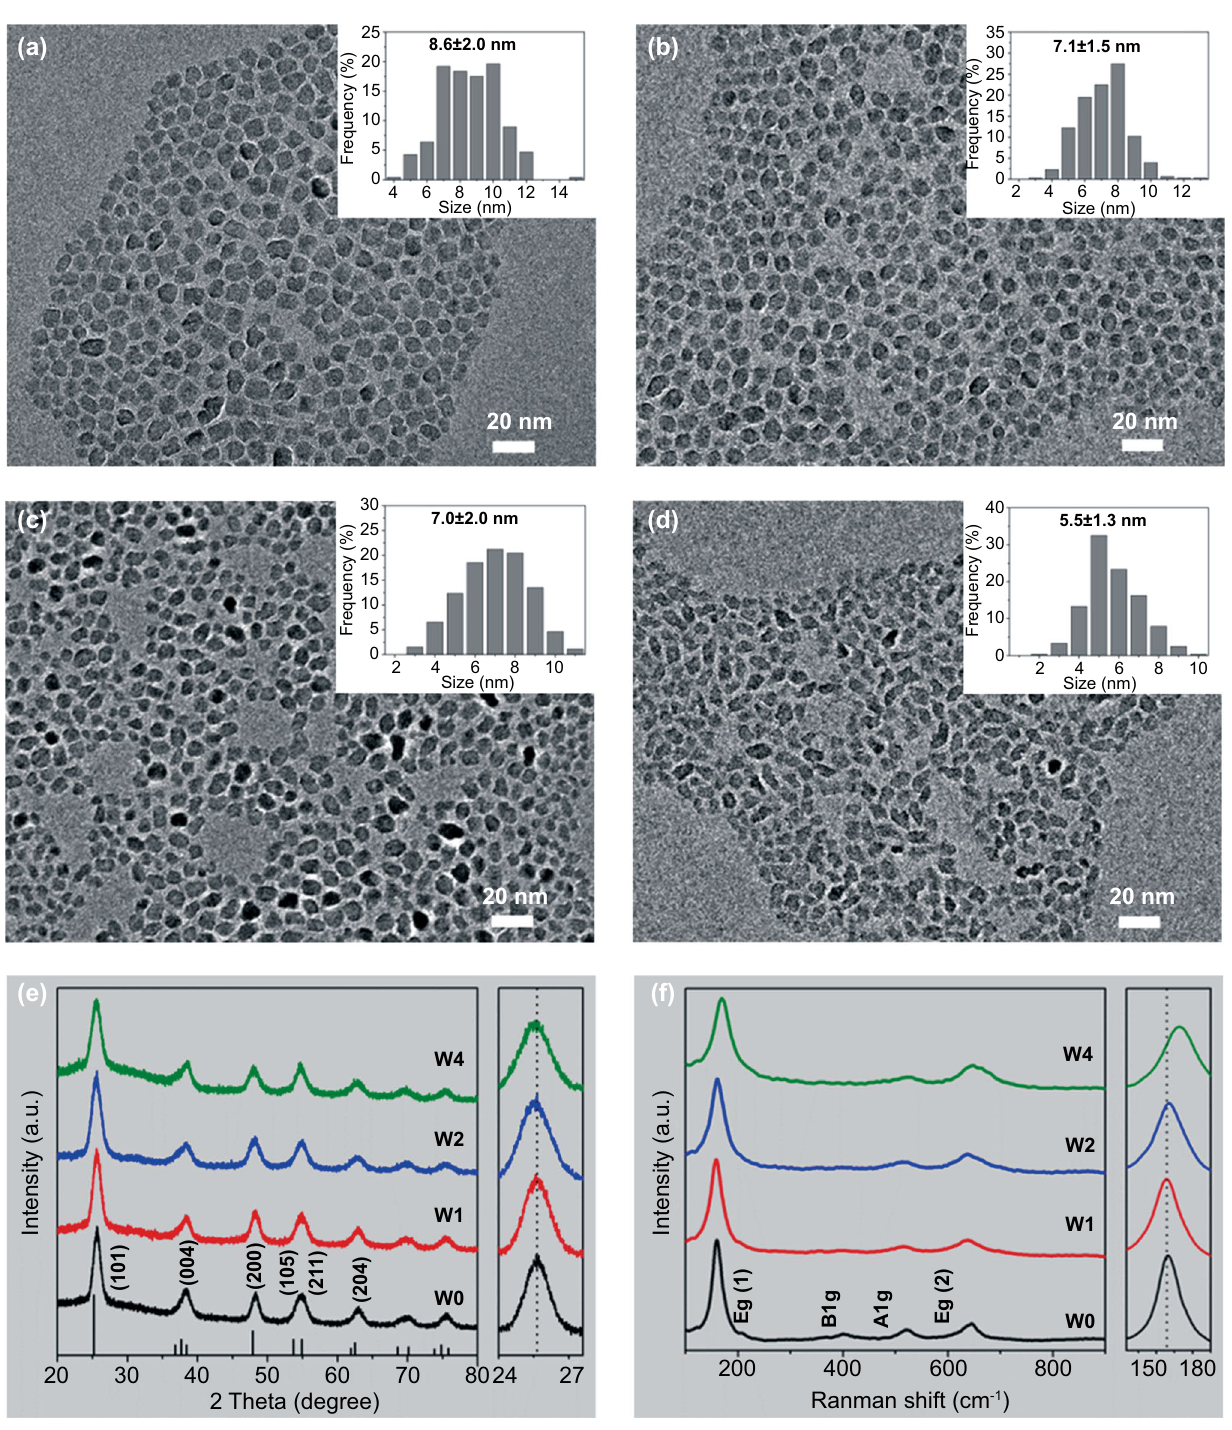
Fig. 1 Morphologies and Structural evolution of W-doped TiO 2 NCs with different W doping content. a–d are TEM images and size distribu- tions (inserts) for W0, W1, W2, and W4, respectively. e XRD patterns. The right panel shows the magnified (101) diffraction peaks. f Raman spectra. The right panel shows the shift of E g (1)